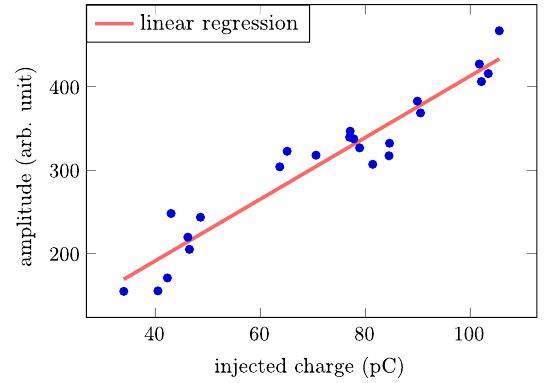
FIG. 10. Linear relation between the amplitude of the energy oscillation extracted from the original data and the charge of the